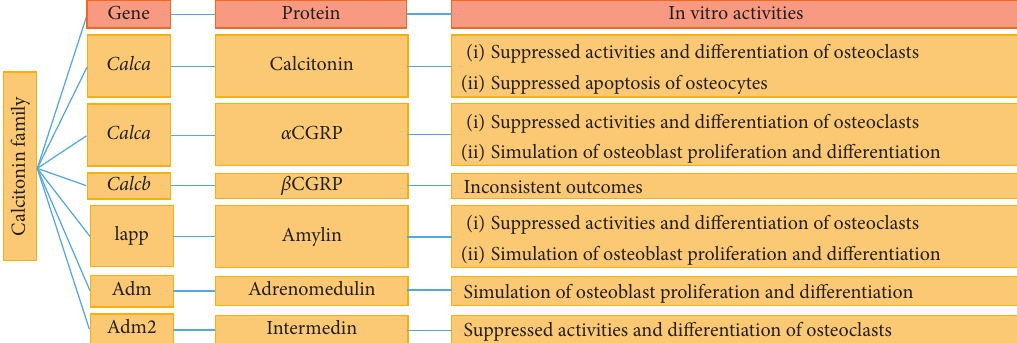
Figure 2: Calcitonin genes family and their respective in vitro effects on bone cells. CGRP, calcitonin gene-related